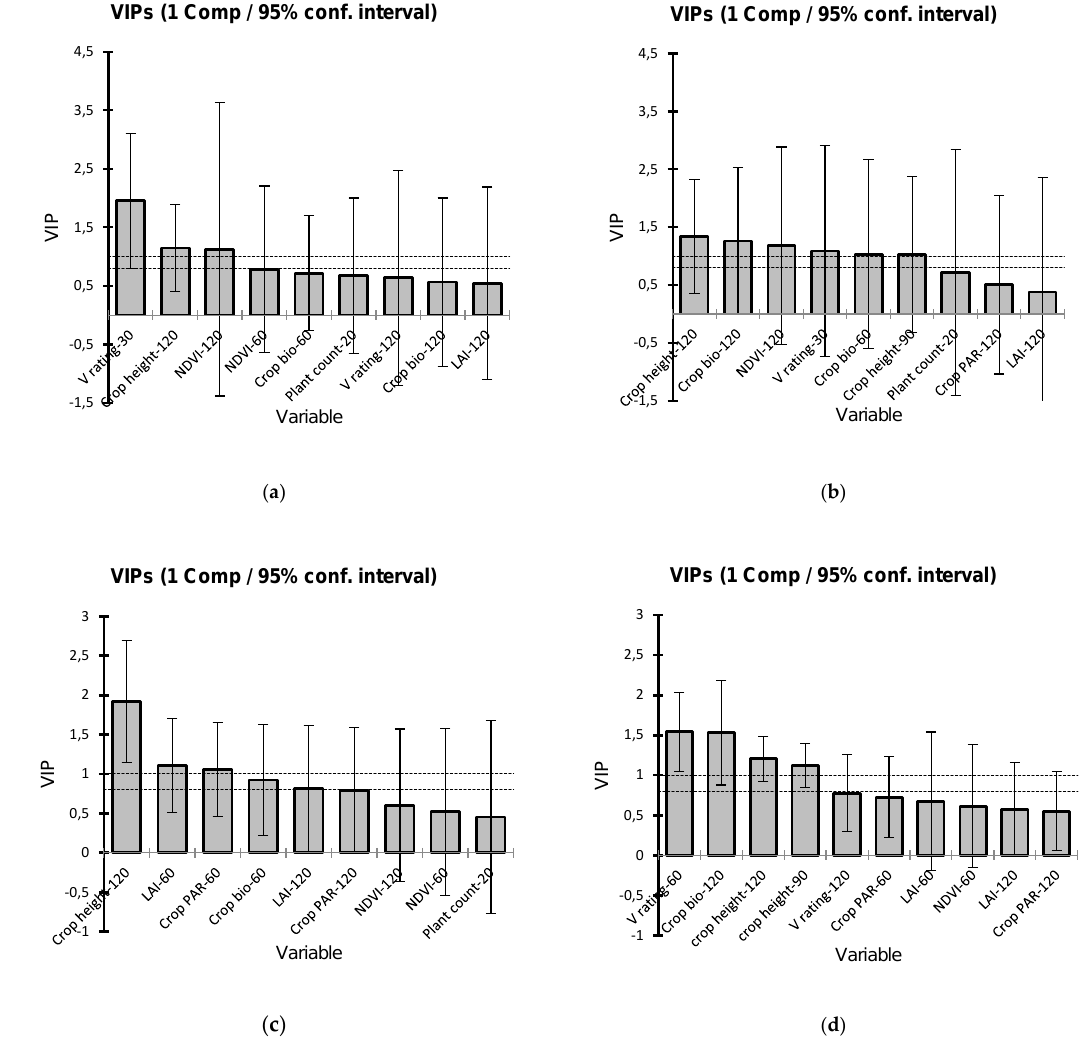
Figure 3. Condobolin 2015-120 days after crop emergence (DAE) regression model r 2 = 0.21 ( a ). Wagga Wagga 2015-120 DAE regression model r 2 = 0.29 ( b ). Condobolin 2016-120 DAE regression model r 2 = 0.51 ( c ). Wagga Wagga 2016-120 DAE regression model r 2 = 0.62 ( d ). Commercial wheat partial least squares regression (PLS-R) based on weed dry biomass as the response variable at 120 DAE showing the variable importance in model projection (VIP) values by several independent crop canopy traits (taken at various DAE) in 2015 and 2016 at Condobolin ( a , c ) and Wagga Wagga ( b , d ). The dotted border line in the graphs identifies the VIPs that are greater than 0.8 and above: these variable thresholds are either moderately (0.8 < VIP < 1) or highly influential (VIP > 1) in weed suppression. The canopy traits include crop biomass, PAR percentage of light interception, leaf area index, visual vigour ratings, plant height, and normalised di ff erence vegetative index